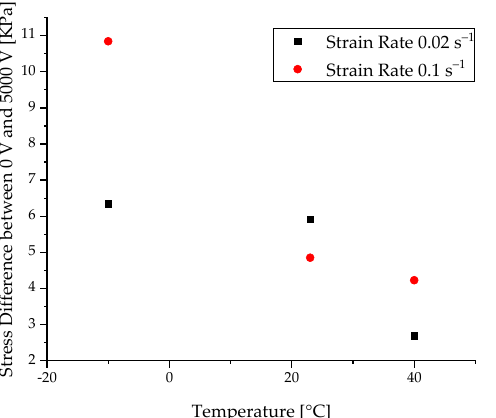
Figure 9. Voltage and temperature dependencies of the difference between maximum stress at 0 V and 5000 V.